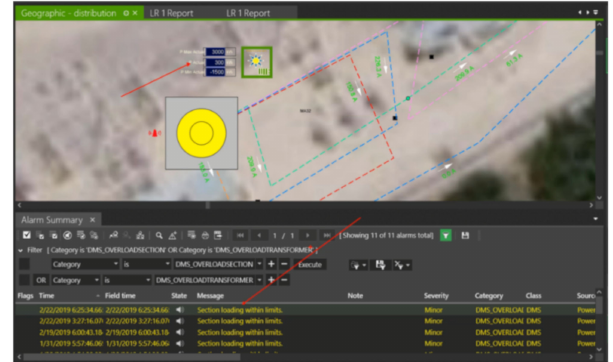
Figure 6. Overload successfully resolved through the EcoStruxure